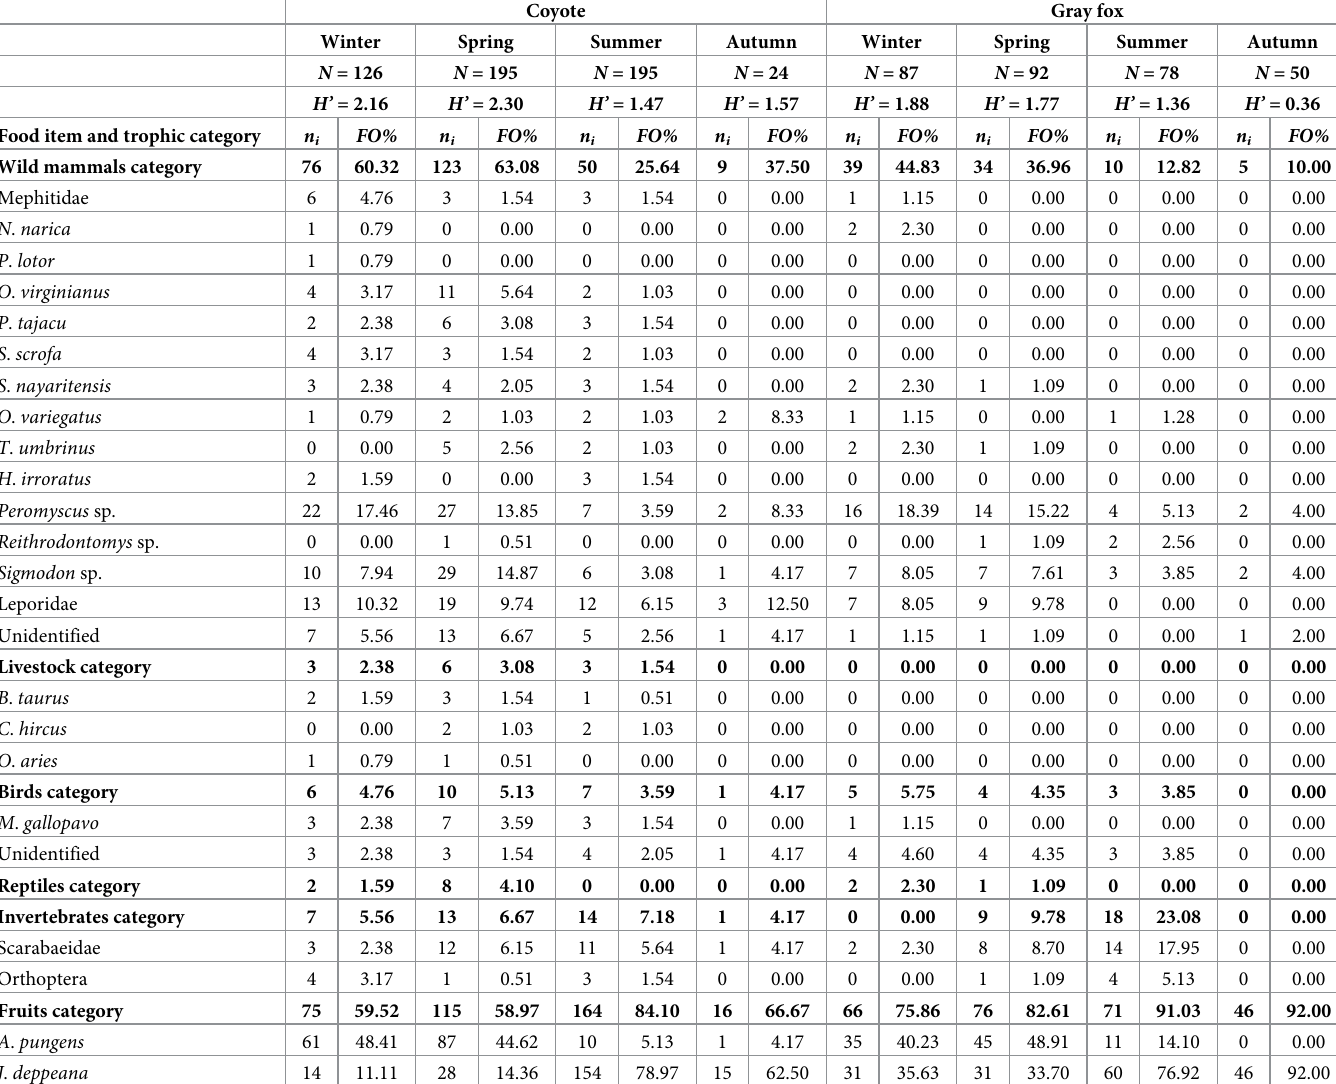
Table 2. Seasonal number of samples ( N ) and trophic diversity ( H’ ) of the coyote and gray fox, as well as seasonal number of occurrences ( n i ) and frequency of occurrence ( FO% ) of food items by trophic category, in both canids diets, in the buffer zone of La Michilia Biosphere Reserve (MBR), Durango,